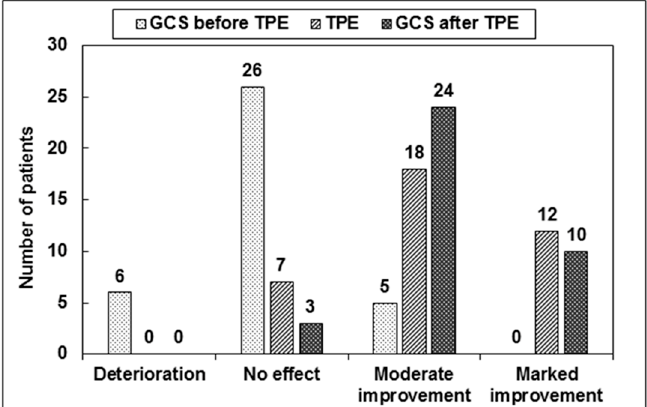
Figure 1. Different response to glucocorticosteroid (GCS) treatment before and after therapeutic plasma exchange (TPE) in 37 clinically isolated syndrome (CIS) and multiple sclerosis (MS) patients. Deterioration was defined as worsened target neurologic deficit or new neurologic symptoms, marked improvement as clinically significant improvement in function, moderate improvement as a definite change of the neurologic deficit without significant impact on function within the functional score, and no effect as unchanged symptoms.